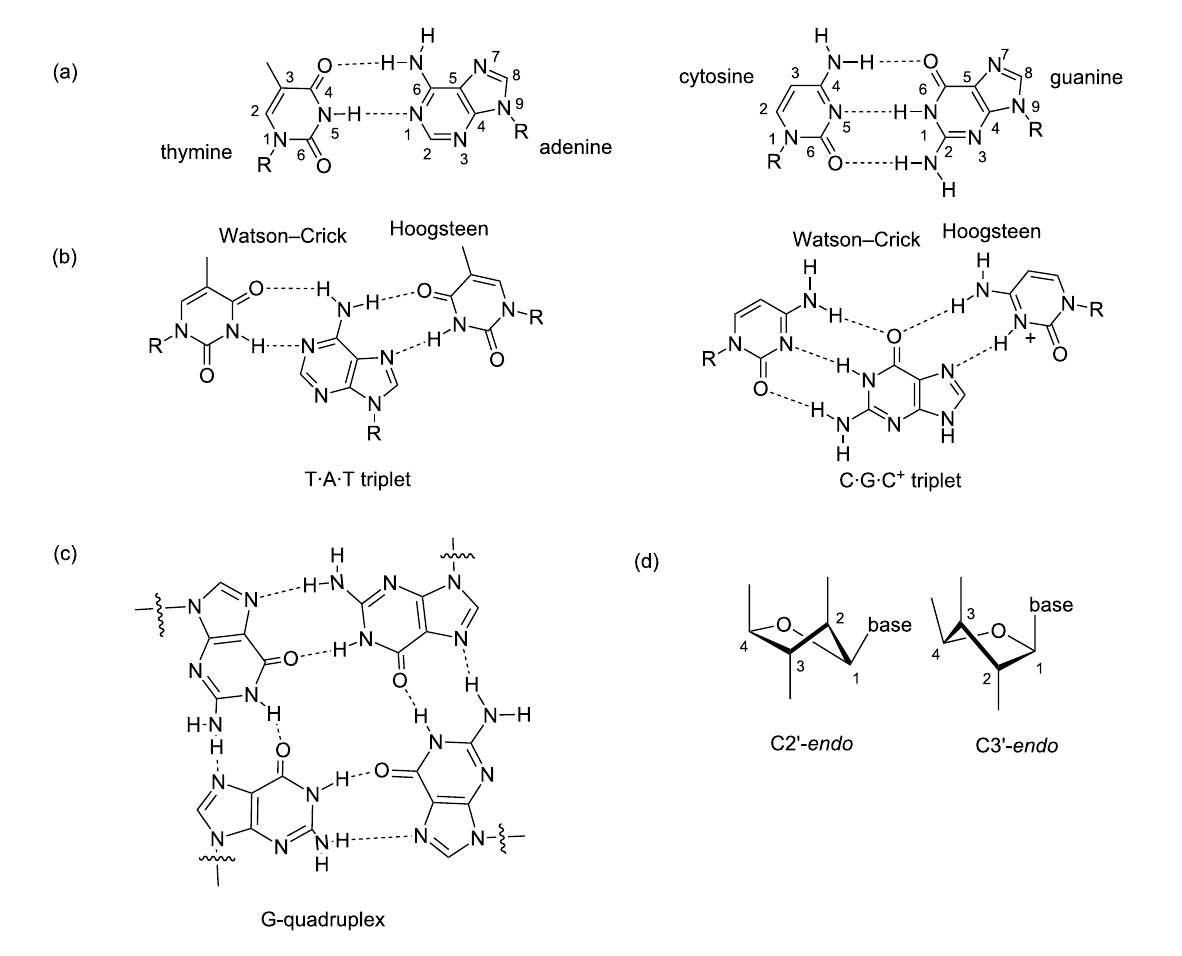
Figure 1: A figure showing the hydrogen bonding patterns observed in (a) duplex (b) triplex and (c) quadruplex DNA structures. (d) Conformations of sugar pucker in